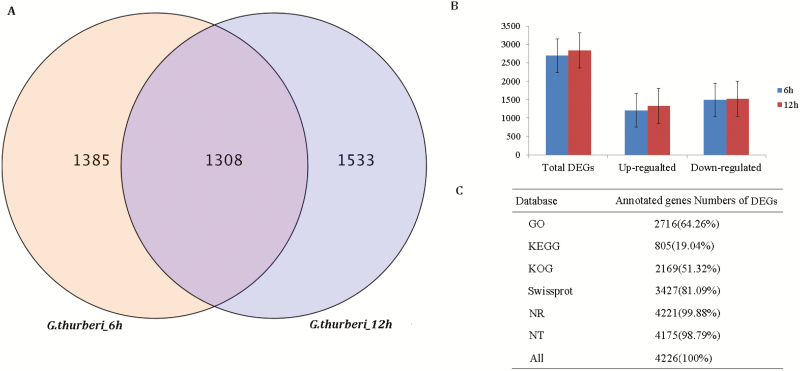
Summary of DEGs in G. thurberi. (A) Venn diagram of DEGs identified in G. thurberi in response to cold stress. The purple zone meant common DEGs at 6 and 12 h post to cold stress. (B) The summary of DEGs was shown in bar graph. The blue bars represent the DEGs at the 6 h of cold stress treatment. The red bars represent the DEGs at the 12 h post-cold stress treatment. Bar indicates standard error. (C) DEGs annotation of G. thurberi by different databases.